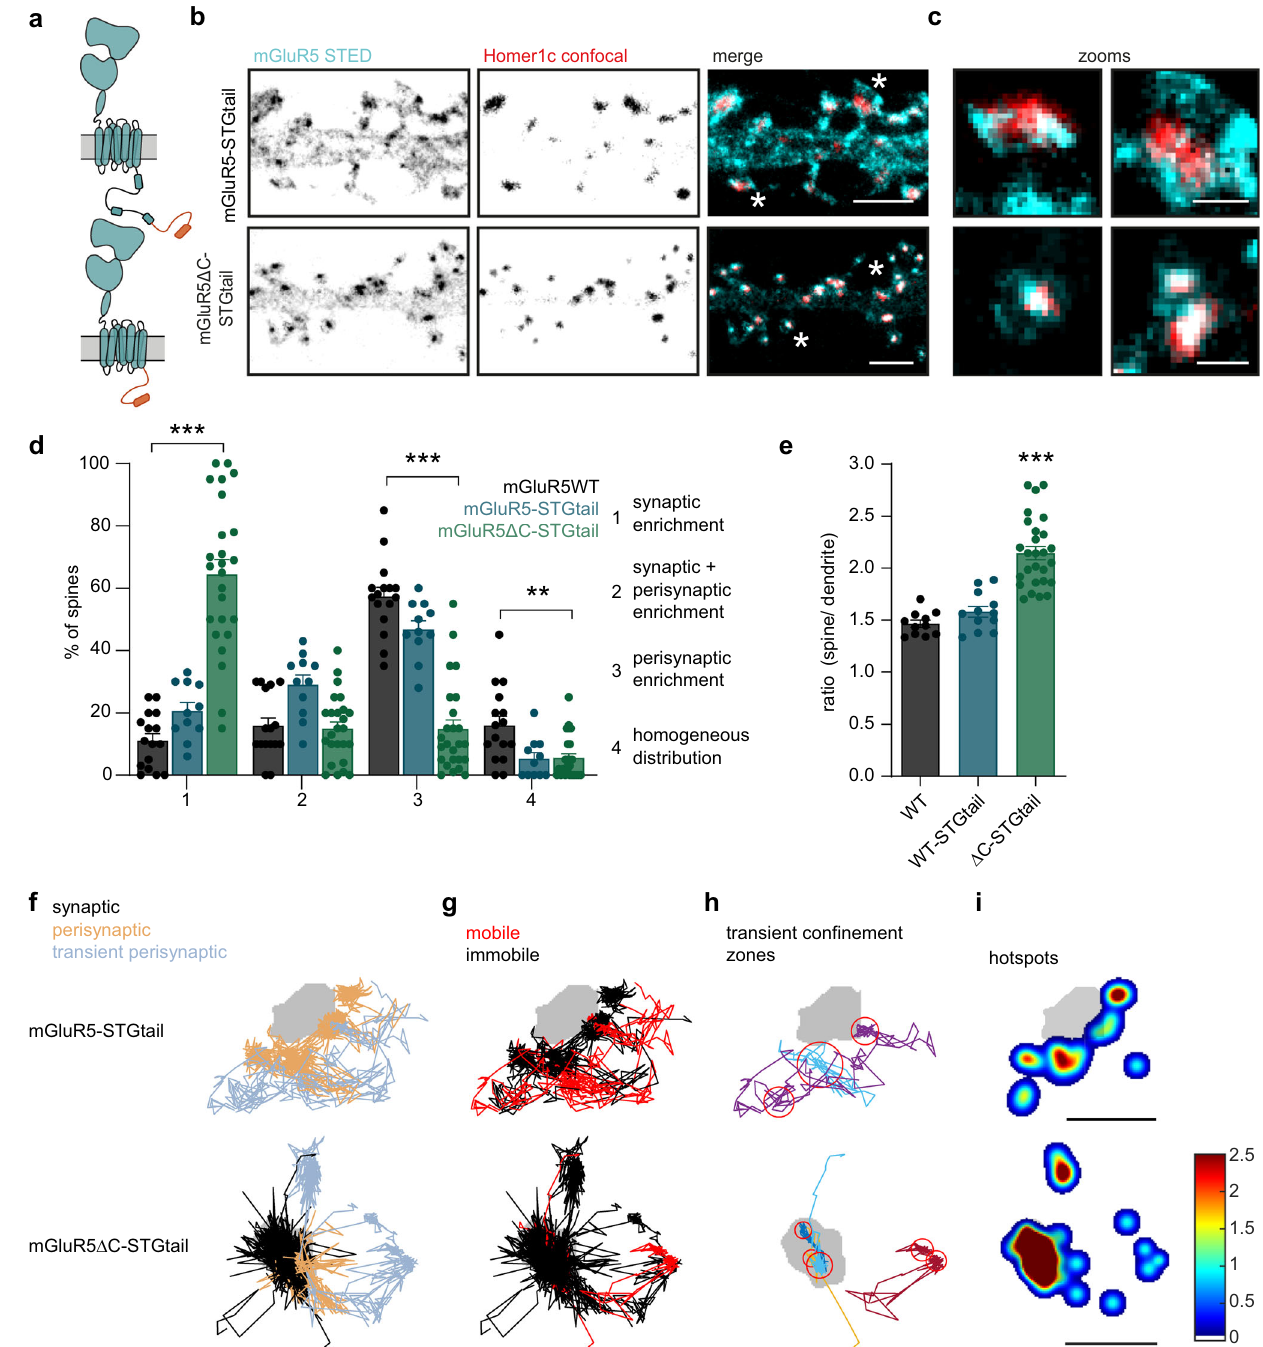
Fig. 6 | TheC-terminaldomain ofmGluR5preventssynapticentry. a Schematic of mGluR5-STGtail(top)and mGluR5 Δ C-STGtail(bottom). b RepresentativegSTED images of dendrite expressing SEP-mGluR5-STGtail and SEP-mGluR5 Δ C-STGtail, additionally labeled with an anti-GFP nanobody Atto647N (cyan), and Homer1c- mCherry (red; confocal). Scale bar, 2 µ m. c Zooms of spines indicated in b with asterisks.Scalebar,500nm. d Quanti fi cationofmGluR5WT(black; n =16),mGluR5- STGtail (blue; n =11), and mGluR5 Δ C-STGtail (green; n =25) localization in spines: (1) synaptic enrichment, (2) synaptic + perisynaptic enrichment, (3) perisynaptic enrichment and (4) homogeneous distribution ( p <0.0001, Kruskal – Wallis test for eachcategorywithDunn ’ smultiplecomparisonstest: p =0.5398formGluR5WTvs. mGluR5-STGtail, p <0.0001 for mGluR5WT vs. mGluR5 Δ C-STGtail and p =0.0011 for mGluR5-STGtail vs. mGluR5 Δ C-STGtail). e Quanti fi cation of the ratio of spine over dendrite intensity of mGluR5WT ( n =11), mGluR5-STGtail ( n =12) and